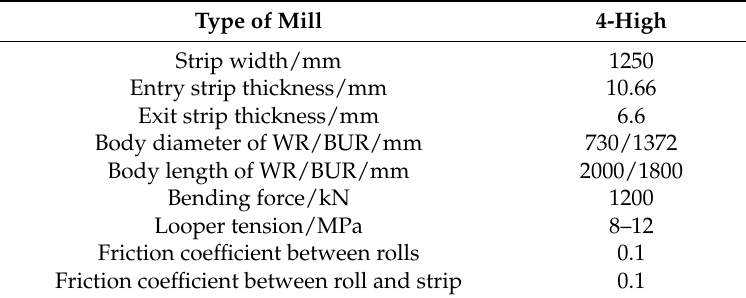
Figure 9. Flow stress curve of the strip material. Table 1. Size and mechanical parameters of the rolling mill investigated.